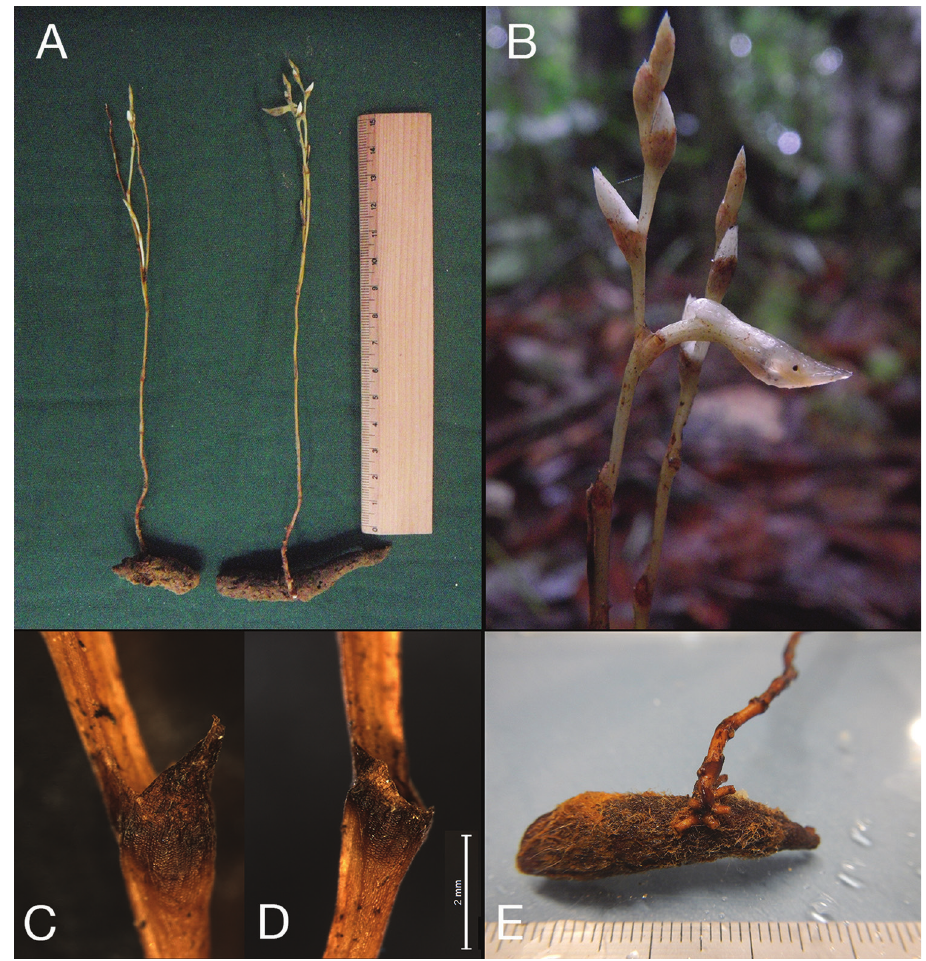
Figure 2. Tropidia connata J.J.Wood & A.L.Lamb. A Gross morphology of two individuals (specimen number 1040, collected in January 5, 2011). Scale in cm B Close-up of the inflorescence C, D Part of inflorescent stem with bracts showing before ( C ) and after ( D ) the detachment of the apical part at the abscission zonev E Subterrestrial part of the flowering individual. Divisions of scale in